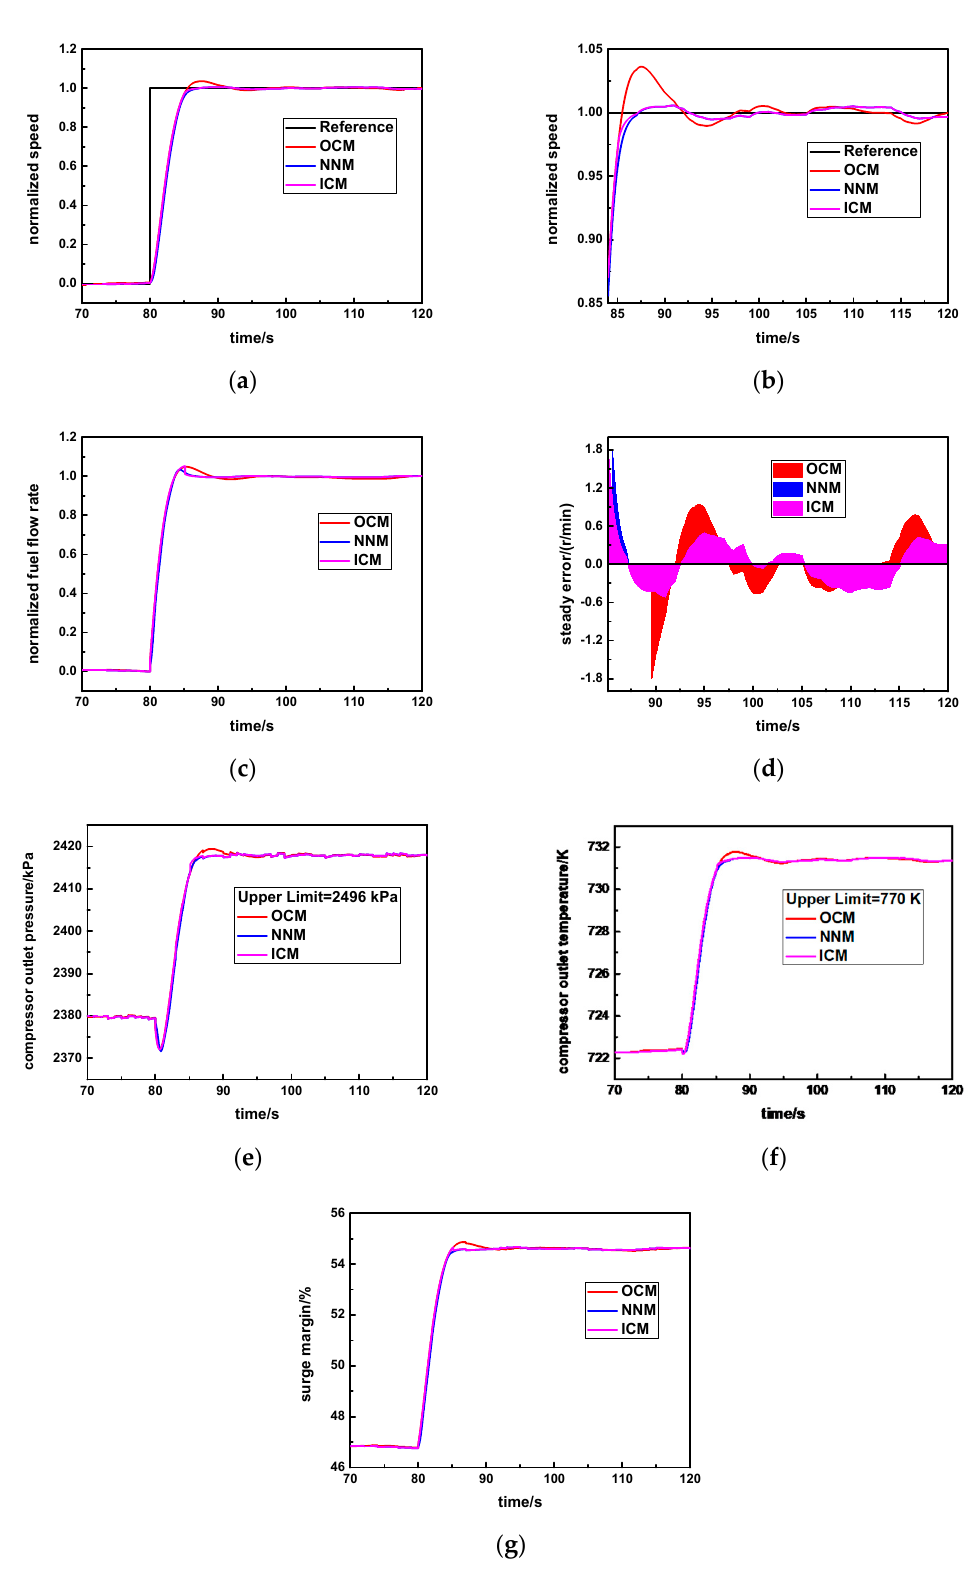
Figure 11. Related parameters distribution of third step test. ( a ) Speed response curve, ( b ) Locally enlarged speed curve, ( c ) Fuel flow rate, ( d ) Steady error, ( e ) Compressor outlet pressure, ( f ) Compressor outlet temperature, ( g ) Surge margin of compressor. Table 4. Tracking performance indexes of three control methods.